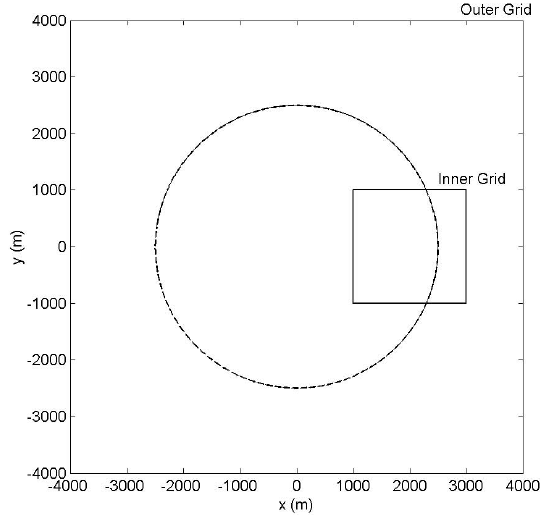
Fig. 8. Computational grids for the simulation of long-wave oscil- lation in a parabolic basin. The dashed circle denotes the elevation of 0.